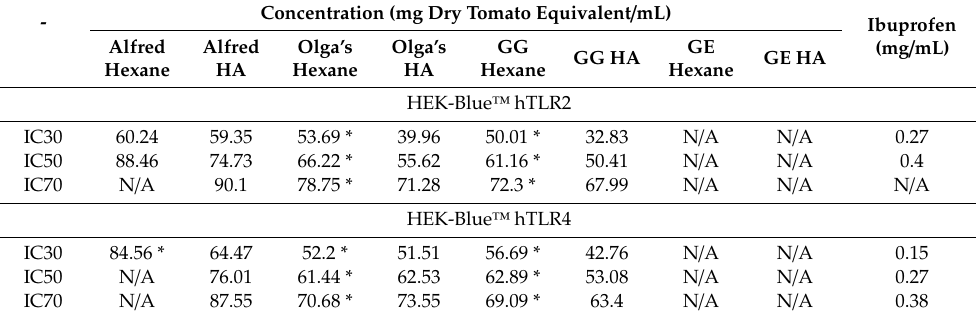
Table 4. Inhibition of SEAP production in HEK-Blue ™ cells following treatment with tomato extracts and